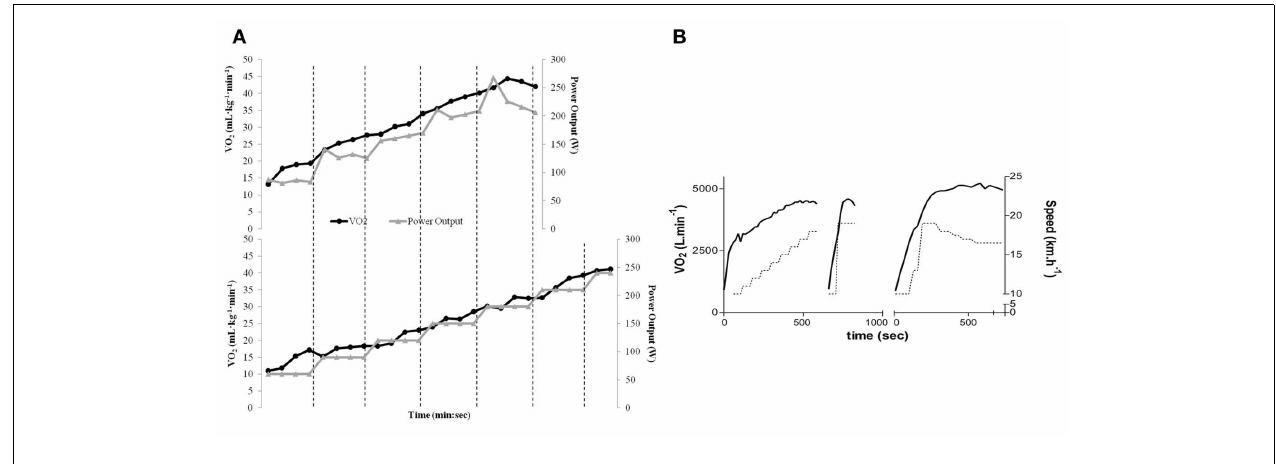
FIGURE 1 | (A) VO 2 and power output data for the self-paced incremental protocol (top) and conventional incremental protocol (bottom) in a representative subject. A higher VO 2 max (group mean ≈ 8%) was achieved in the self-paced incremental protocol during submaximal workload. (B) VO 2 and speed data for the conventional incremental test (left) + verification phase (middle) and